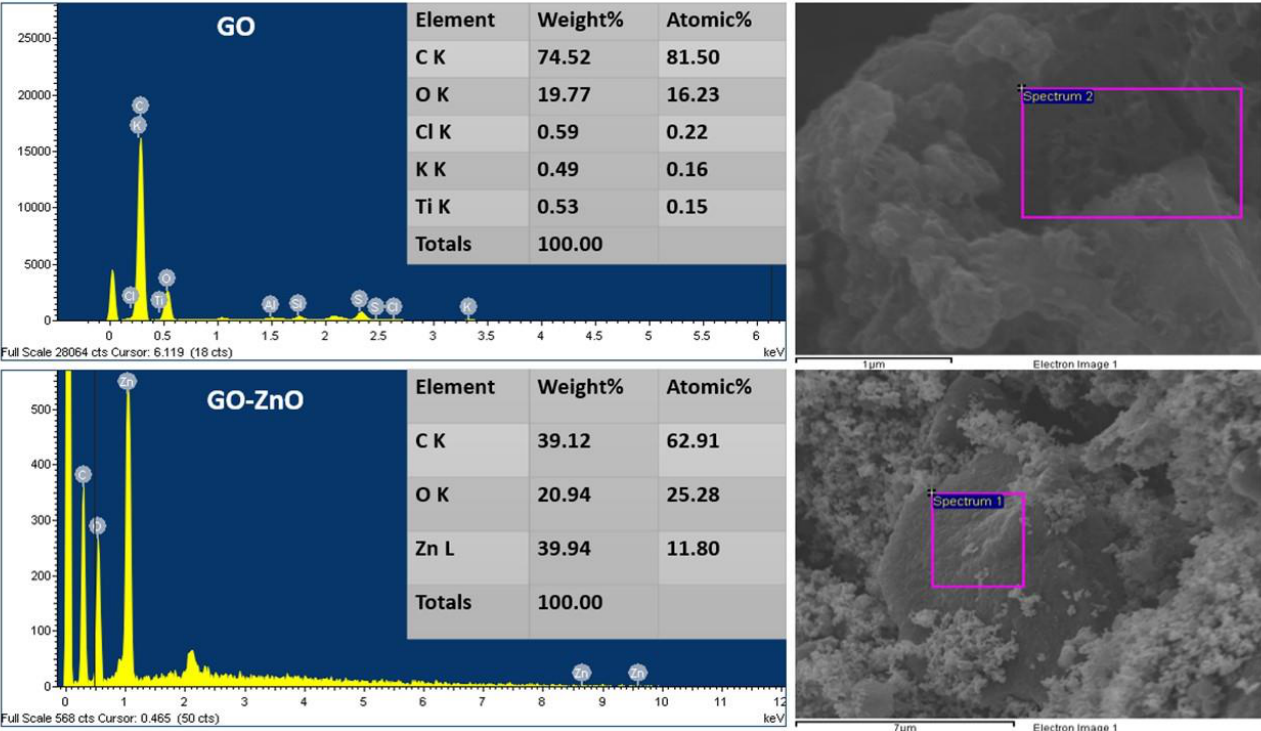
Figure 3. EDX analysis of as-prepared cellulose catalysts GO and GO-ZnO.